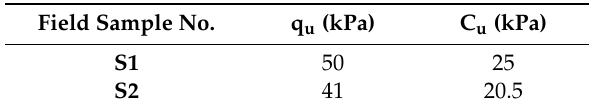
Table 8. Summary of unconfined compression strength test result.